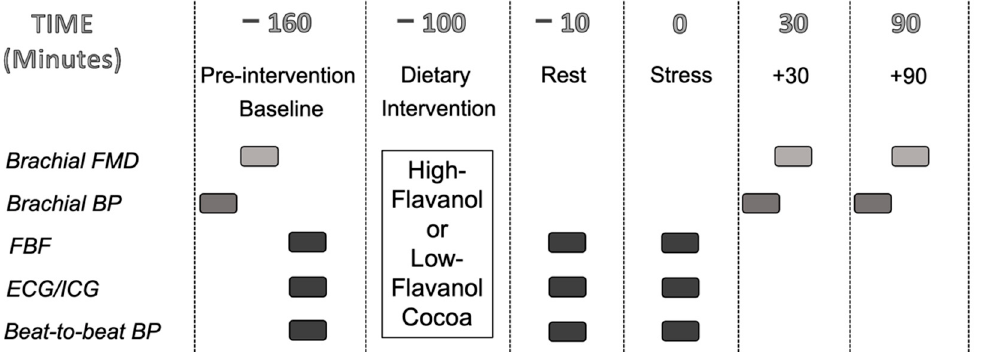
Figure 1. Experimental Study Design.